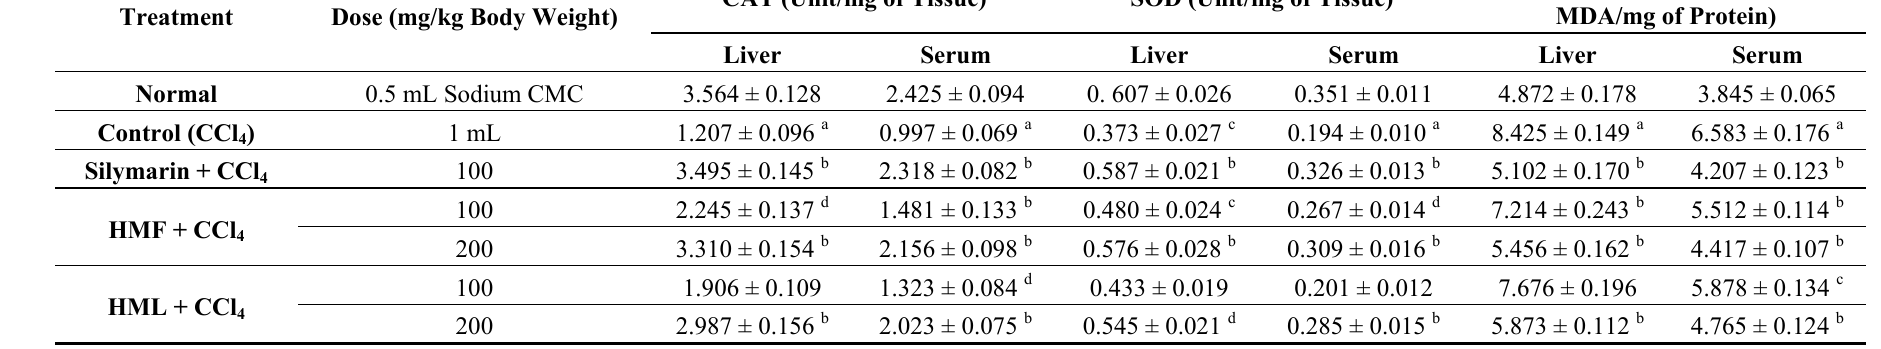
The results are the mean ± S.E.M. ( n = 6), a p < 0.001, between the normal and CCl and treated groups. Table 4. The effect of HMF, HML and silymarin on antioxidant enzymes and lipid peroxidation in CCl 2-thiobarbituric acid reactive substance; MDA, malondialdehyde.